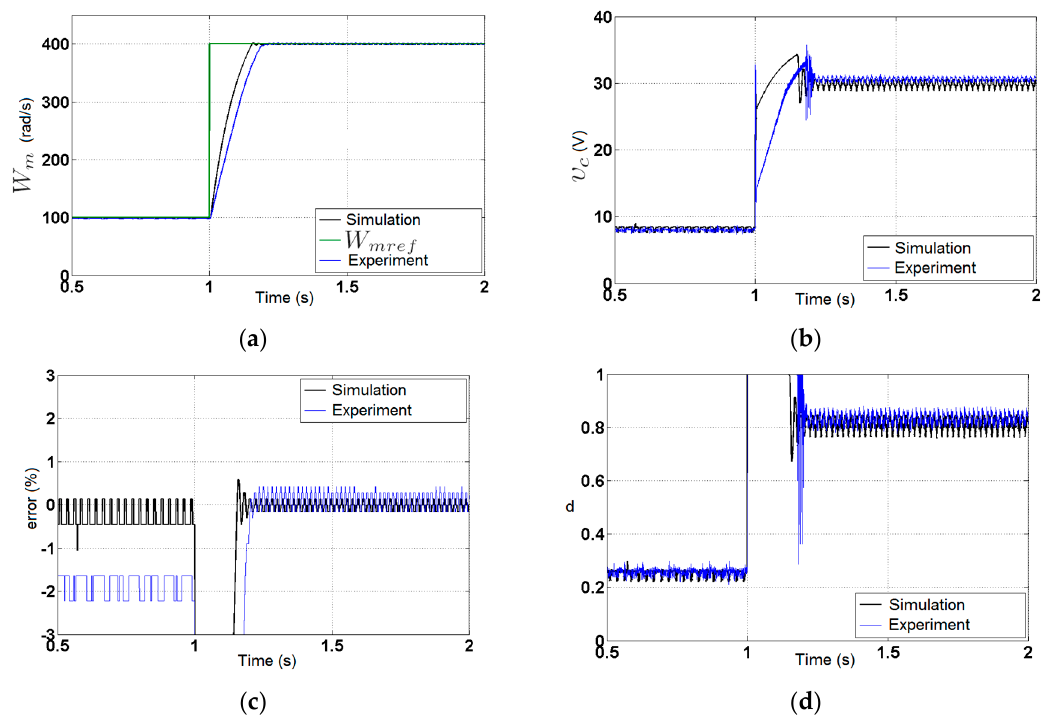
Figure 3. Numerical and experimental behavior when there is a change in the speed reference signal ( W mref ): ( a ) motor speed signals ( W m ); ( b ) motor supply voltage ( V a = υ c ) ; ( c ) speed error; and ( d ) duty cycle.